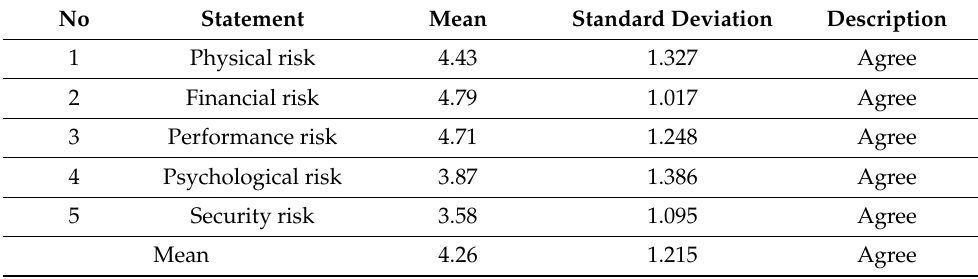
Table 3. Tourism Risk Perception (TRP) Descriptive Statistics.